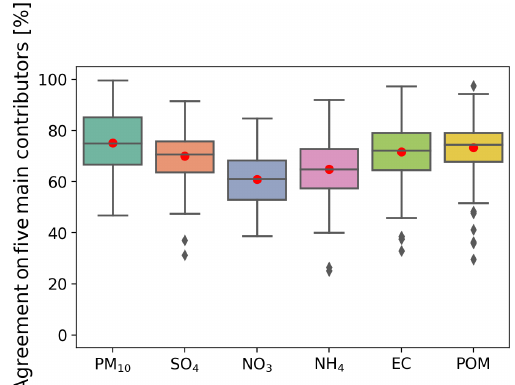
Figure 11. Agreement on the determination of the five main country contributors for PM 10 , SO 4 , NO 3 , NH 4 , EC, and POM in percent, determined over all of the studied cities using the nine grid cells definition and for all 4d forecasts. The line that divides the box into two parts represents the median of the data. The ends of the box show the upper and lower quartiles. The extreme lines show the highest and lowest values excluding outliers, which are represented by grey diamonds. The red dots correspond to the mean of each data